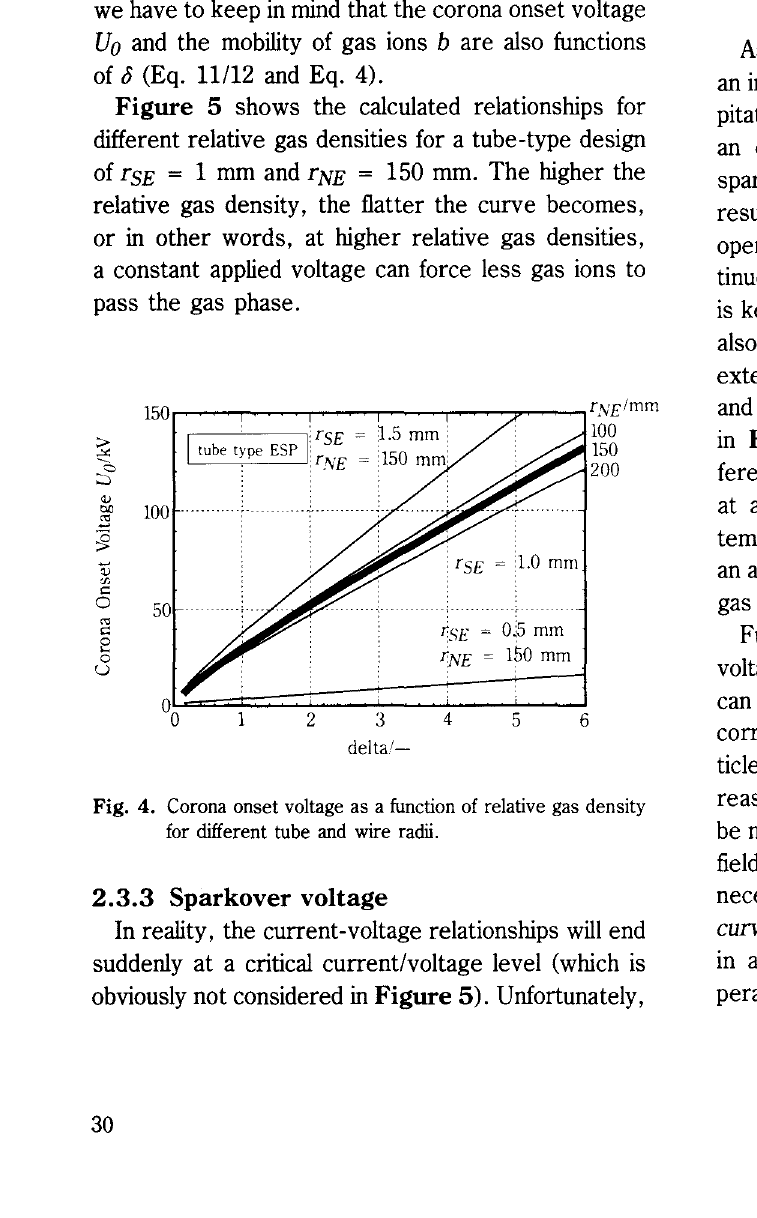
Fig. 5 Electrical current density at collecting wall as a function of applied voltage for different relative gas